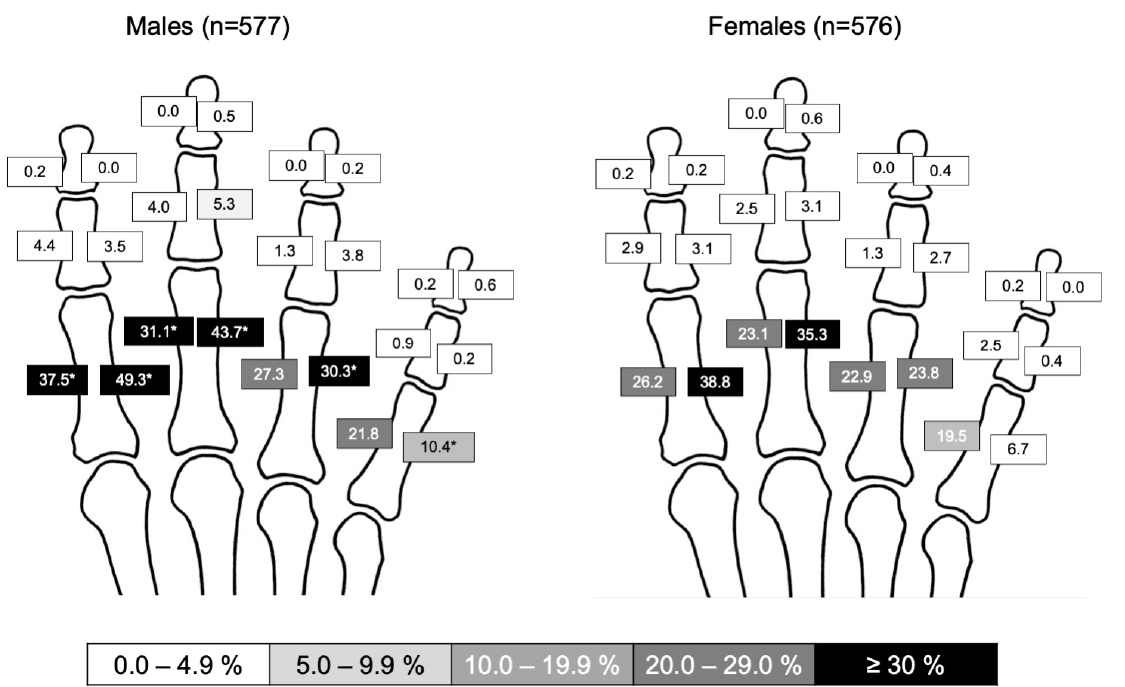
Figure 4. Distribution of periosteal lesions at phalanges. Relative frequencies (%) per region. Signifi- cantly higher frequencies are marked with an asterisk (*); p -values derived from Chi 2 tests.